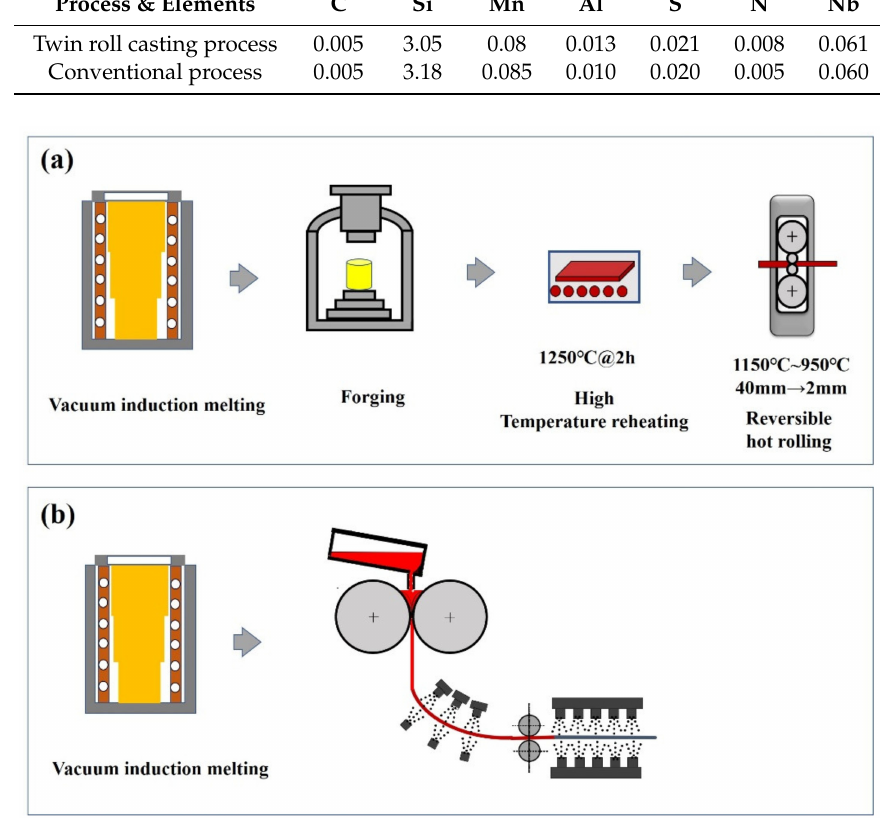
Figure 1. The schematic diagram of conventional hot rolling process ( a ) and twin-roll casting process ( b